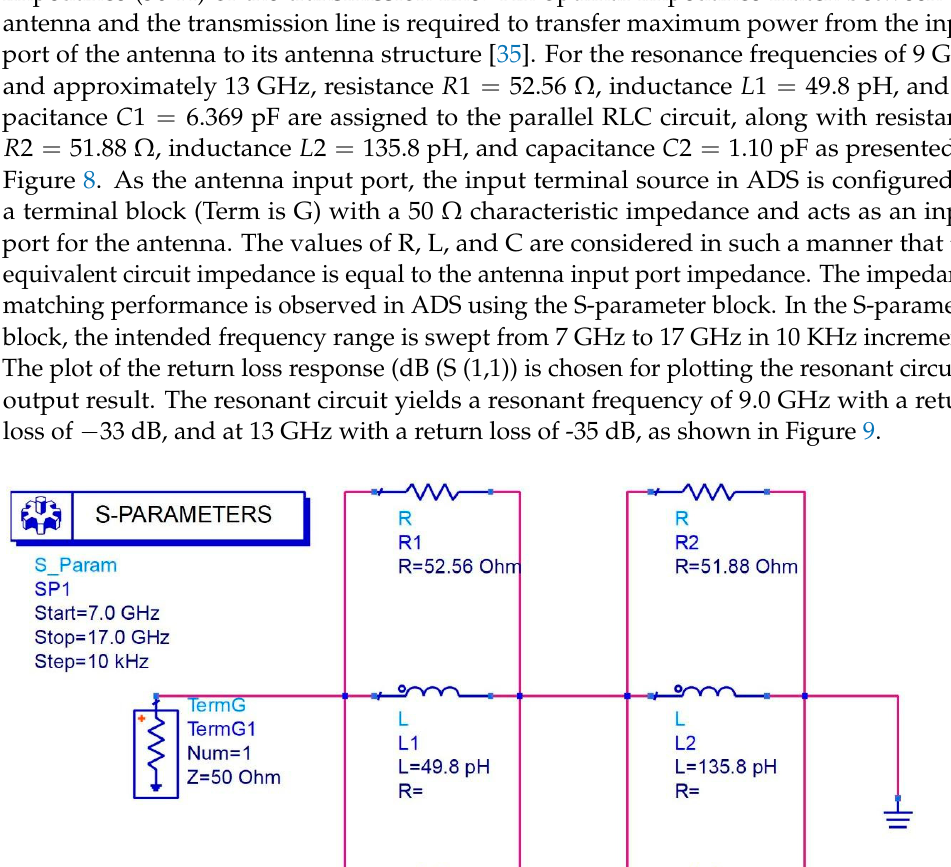
Figure 7. Gain vs. frequency plot of the proposed MPA.